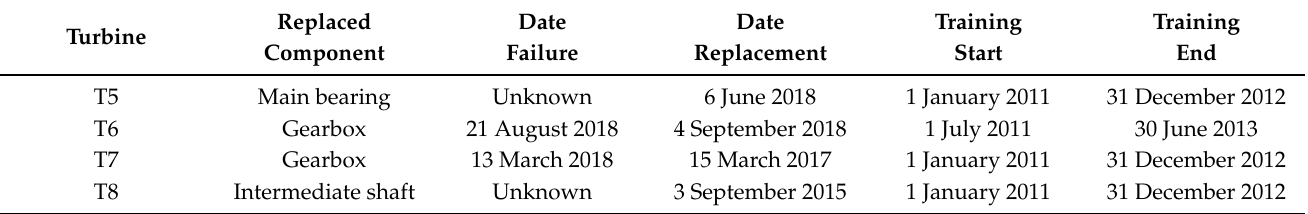
Table 2. Failure and replacement times of subcomponents that occurred on the target wind turbines